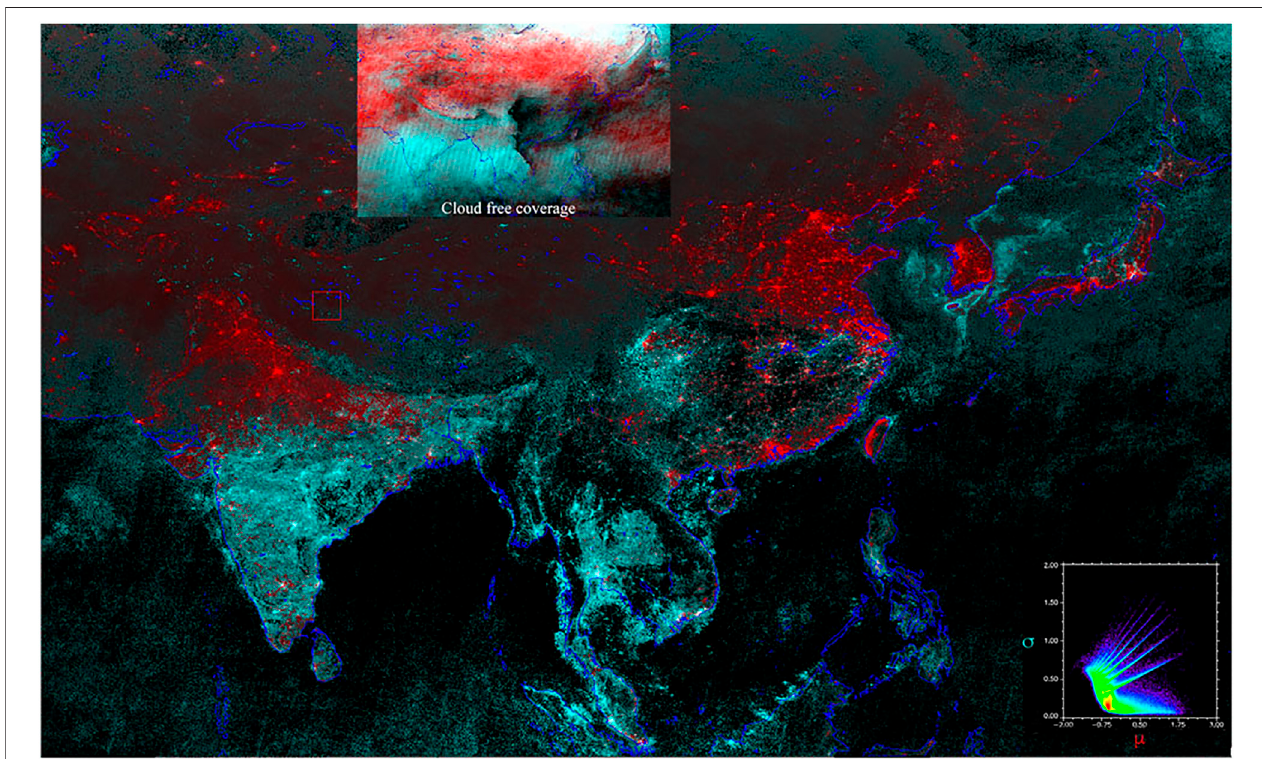
FIGURE 1 | (B) Spatiotemporal moments for Log 10 VIIRS monthly radiance for Asia in 2019 + 2020. Mean ( μ ) monthly Log 10 radiance (red) is consistently high for lighted development and relatively low elsewhere, while the standard deviation ( σ ) of monthly Log 10 radiance (cyan) is low for lighted development and relatively high elsewhere. Lighted development in summer monsoon areas has high μ and σ so appears white. The μ vs σ distribution (inset scatterplot) shows spurs of rapidly increasing σ with μ for high latitude coverage gaps in summer months. Individual spurs of increasing μ and σ on upper scatterplot correspond to brighter sources with different summer gap lengths (inset left) . Monotonically decreasing range of σ for μ > 1 nW/cm2/sr on the lowest limb of the distribution results from increasing temporal stability (decreasing σ ) with increasing brightness for sources outside the summer monsoon gap areas (inset right) . Inset map of μ and σ for cloud free acquisitions per month for 2019 + 2020(top) shows a similar pattern as a result of monsoon cloud cover.